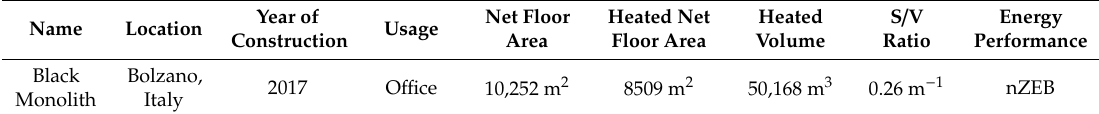
Figure 2. Black Monolith in the framework of the NOI TechPark. Credits: Ivo Corr à | IDM Südtirol-Alto Adige. Table 1. Key characteristics of the case